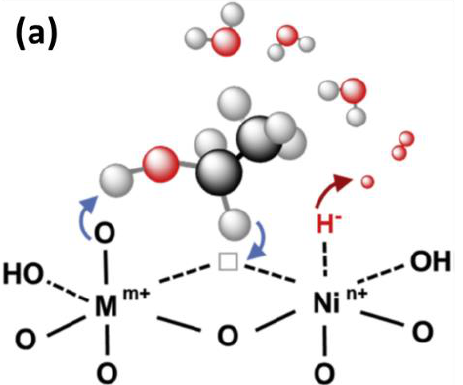
Figure 13. ( a ) OSRE on Mg 2 AlNi x H z O y oxyhydride catalysts. Ni n+ : Ni 2+ or Ni δ+ , M m+ : Mg 2+ or Al 3+ and : anionic vacancy. The positions of anionic vacancy and hydride species are arbitrary [85]; ( b ) ODRM on CeNi x Al 0.5 H z O y oxyhydride catalysts. Ni n+ : Ni 2+ , Ni δ+ , Ce m+ = Ce 4+ , and Ce 3+ (Al 3+ can re- place a cerium cation in the solid solution). : anionic vacancy, red balls: oxygen, black balls: car- bon, white balls: hydrogen. The positions of anionic vacancy and hydride species are arbitrary [89].